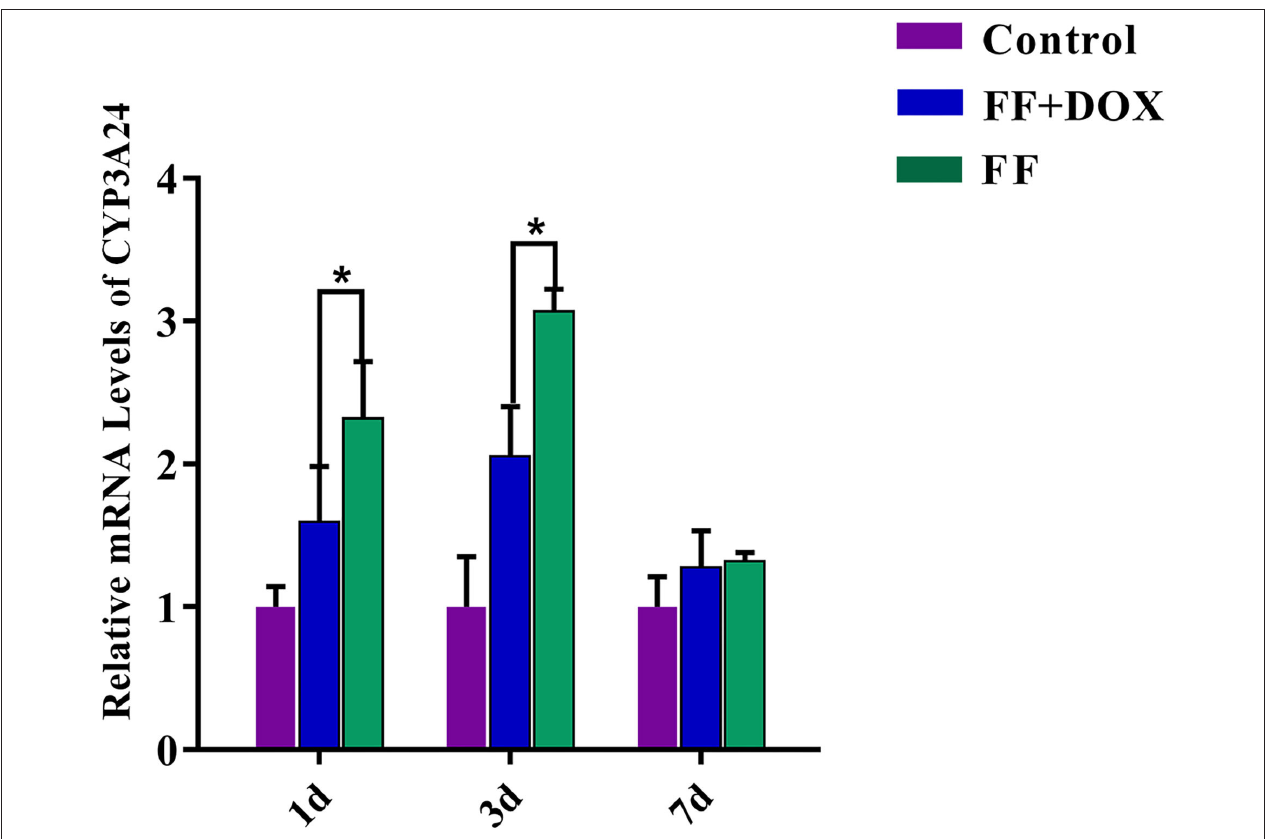
FIGURE 7 | CYP3A24 gene expression in goats. The data were expressed as mean ± standard deviation (error bars) ( n = 3). *( P < 0.05) indicates statistically significant difference between the combined group (FF + DOX) and the single group